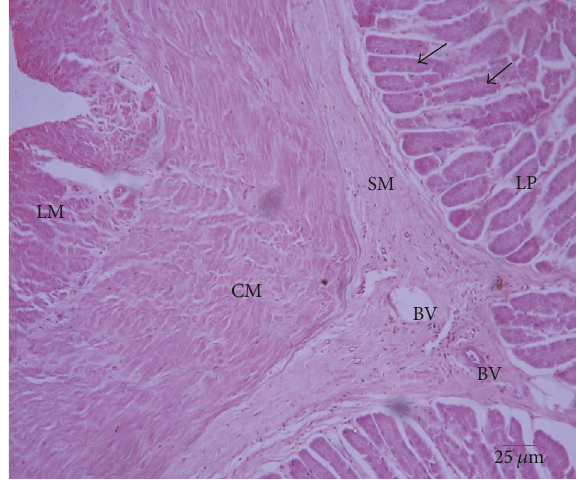
Figure 6: Transverse section of esophagus: lamina propria (LP), submucosa (SM), blood vessel (BV), inner circular muscle (CM), and outer longitudinal muscle (LM). Arrows: tubular glands.